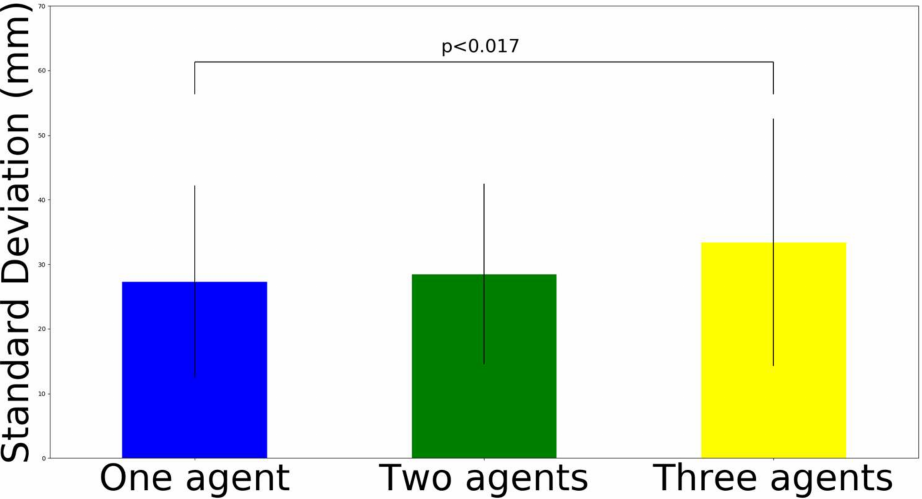
Figure 11. Standard deviation results on orthogonal vertical movement